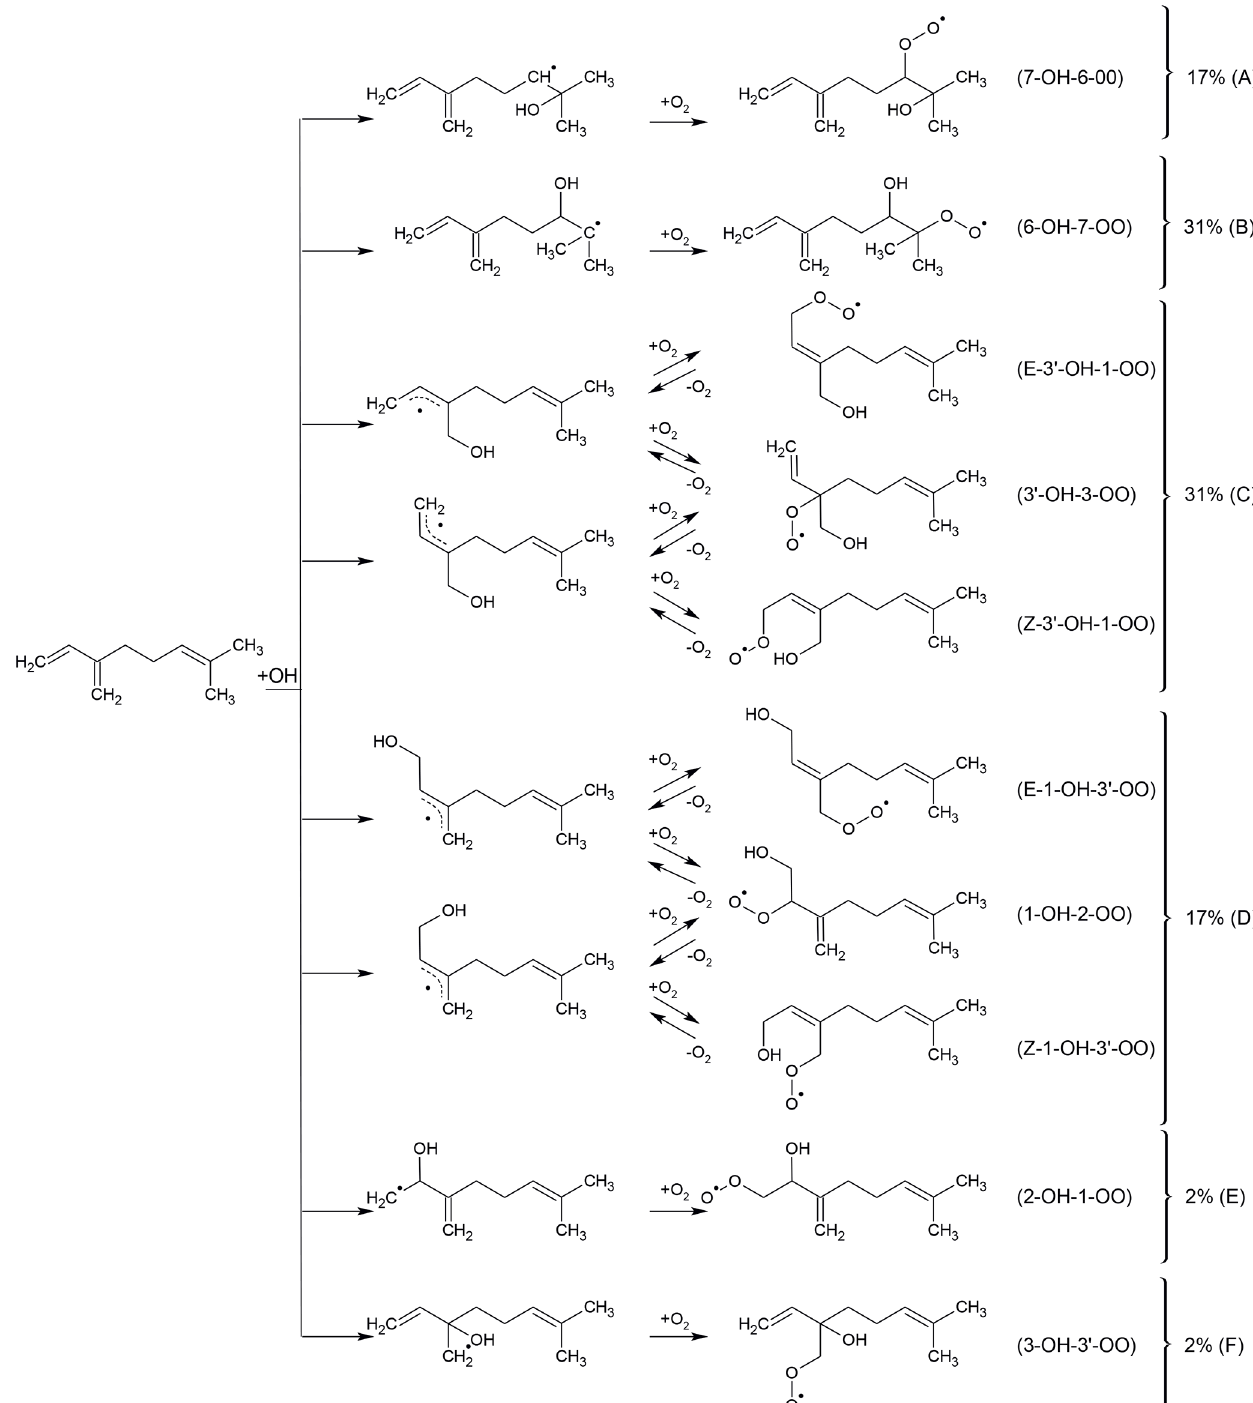
Figure 2. Peroxy radicals formed from the addition of OH to the double bonds in myrcene. MyO 2 formed from the OH addition to the isoprenyl part of myrcene leads to the formation of MyO 2 species that are expected to rapidly interconvert by oxygen abstraction and elimination like in isoprene (Peeters et al., 2014). Assuming reaction rate constants for oxygen abstraction and elimination like in isoprene, 3 (cid:48) − OH − 3 − OO and 1 − OH − 2 − OO are expected to have the highest yields among the MyO 2 species that can interconvert. MyO 2 yields are predicted using SAR by Peeters et al.